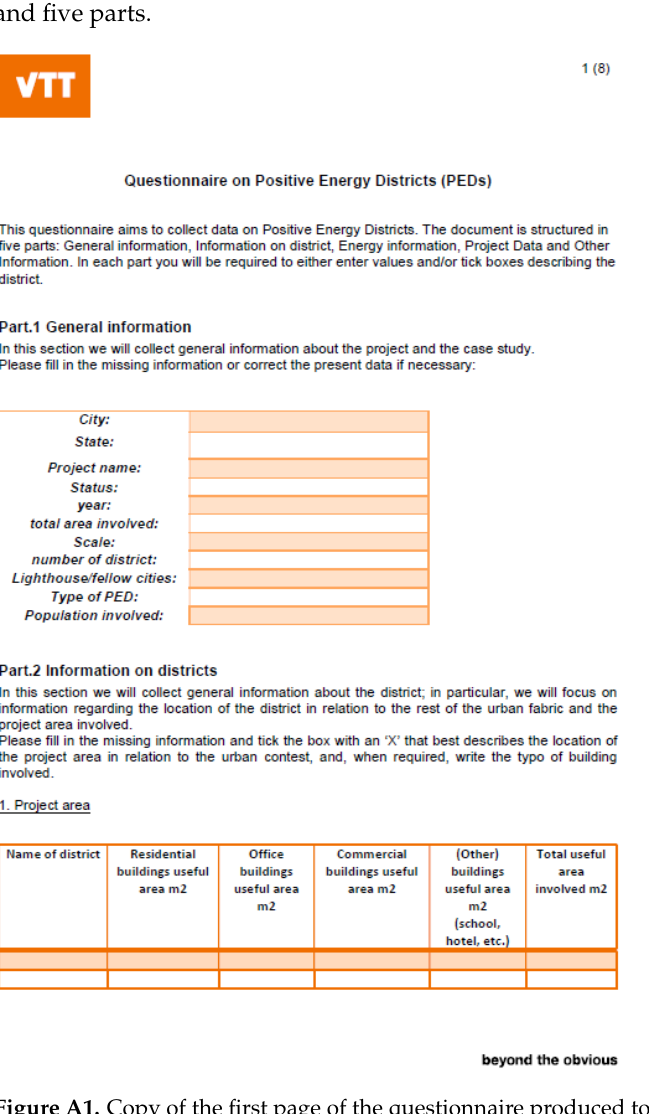
Figure A1. Copy of the first page of the questionnaire produced to conduct this study.